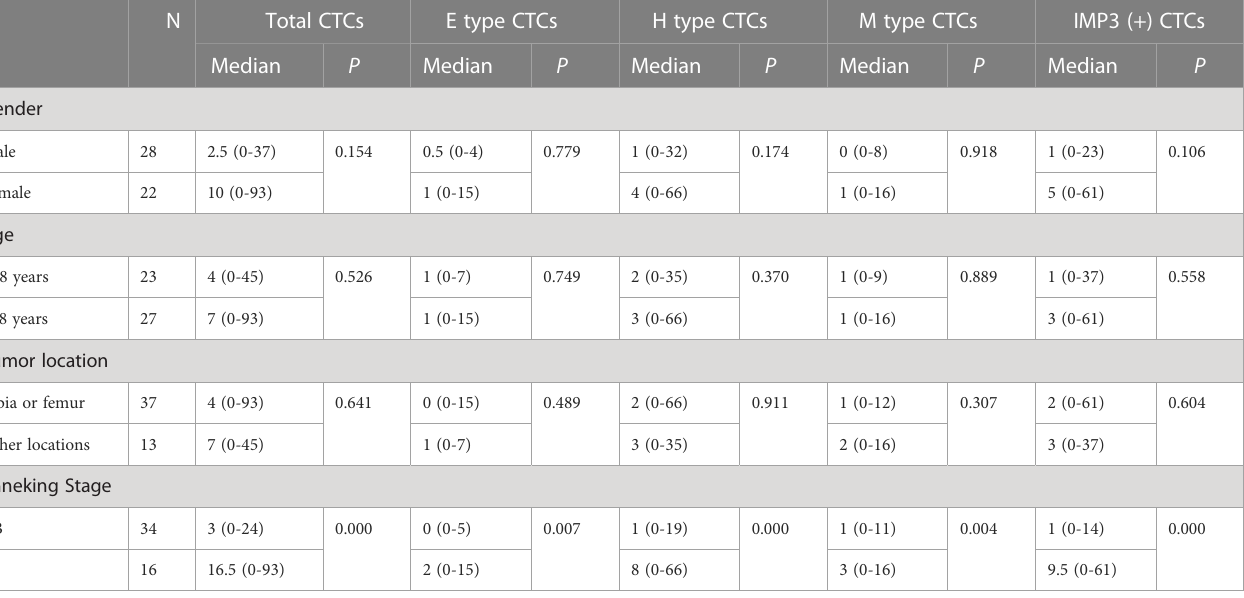
TABLE 3 Association between CTCs and clinical variables in 50 osteosarcoma patients.